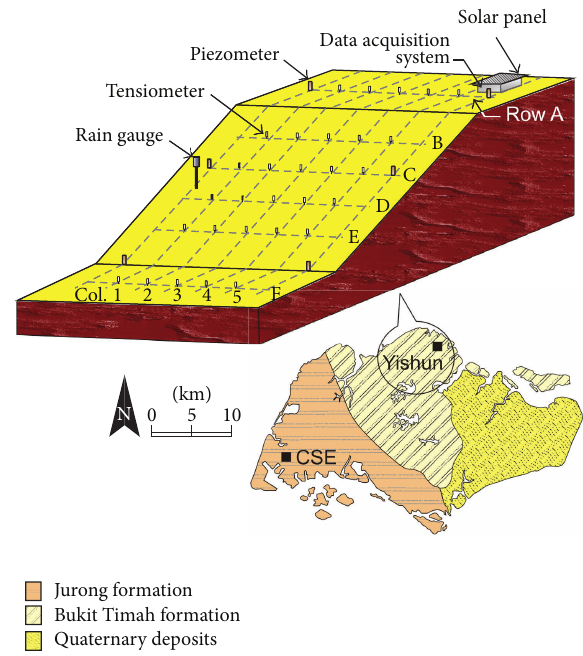
Figure 2: Schematic diagram of typical arrangement of instrumen- tation and location of the study slopes adapted from Mustafa et al., 2012.